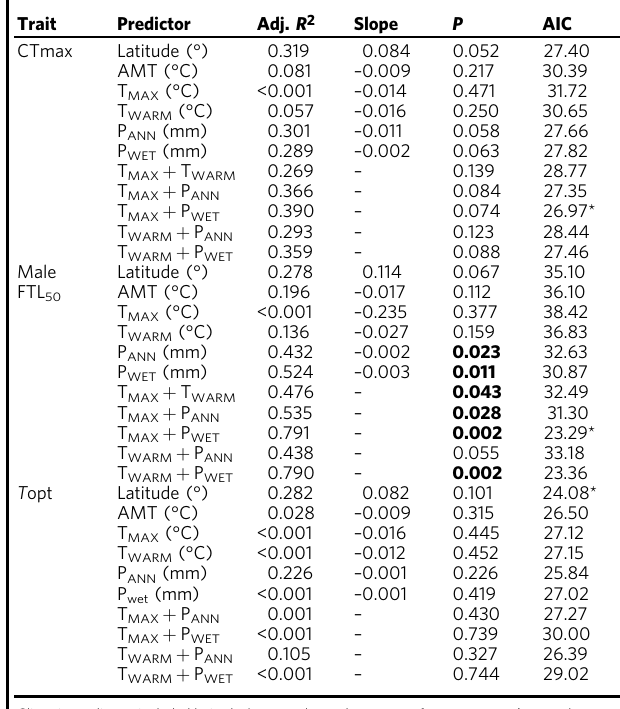
Table 1 Linear regression analysis was used to investigate the association between CTmax, male FTL 50 and T opt and climate across ten Drosophila species (only data from eight species were available for T opt).